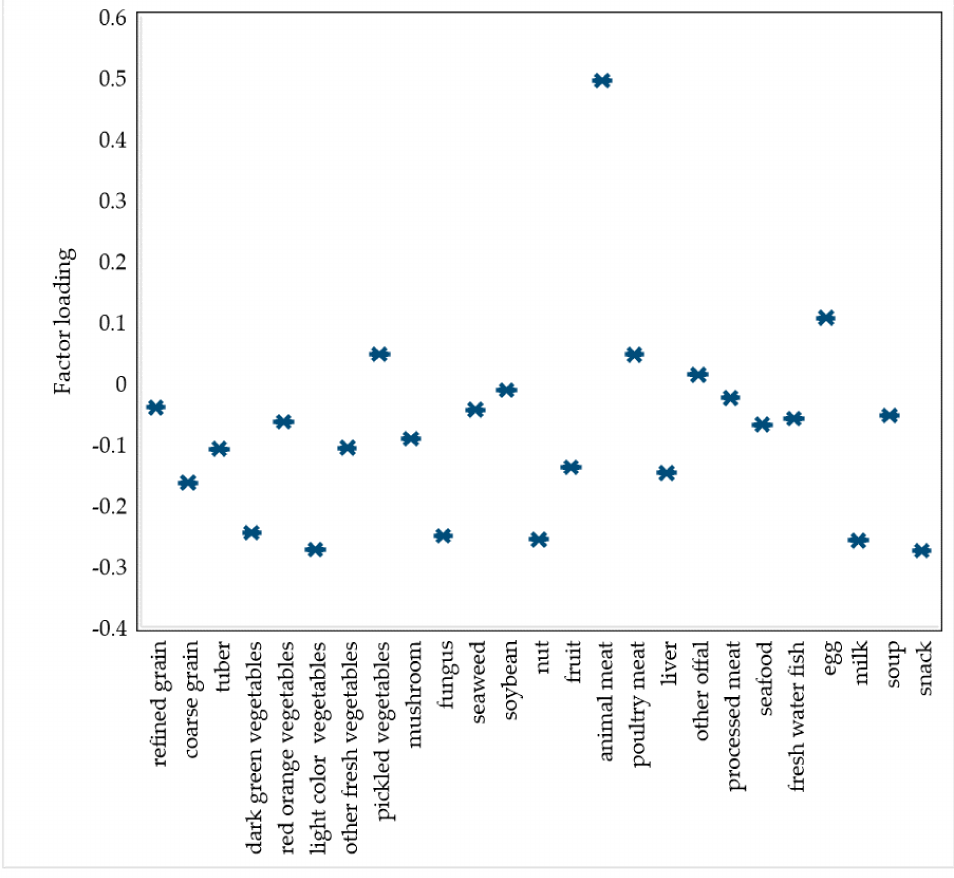
Figure 2. The factor loading of each food item in the postpartum depression-related dietary pattern. Reduced rank regression (RRR) analysis was conducted with the intake frequencies of 21 food groups as input variables and the EPDS-10 score as the response